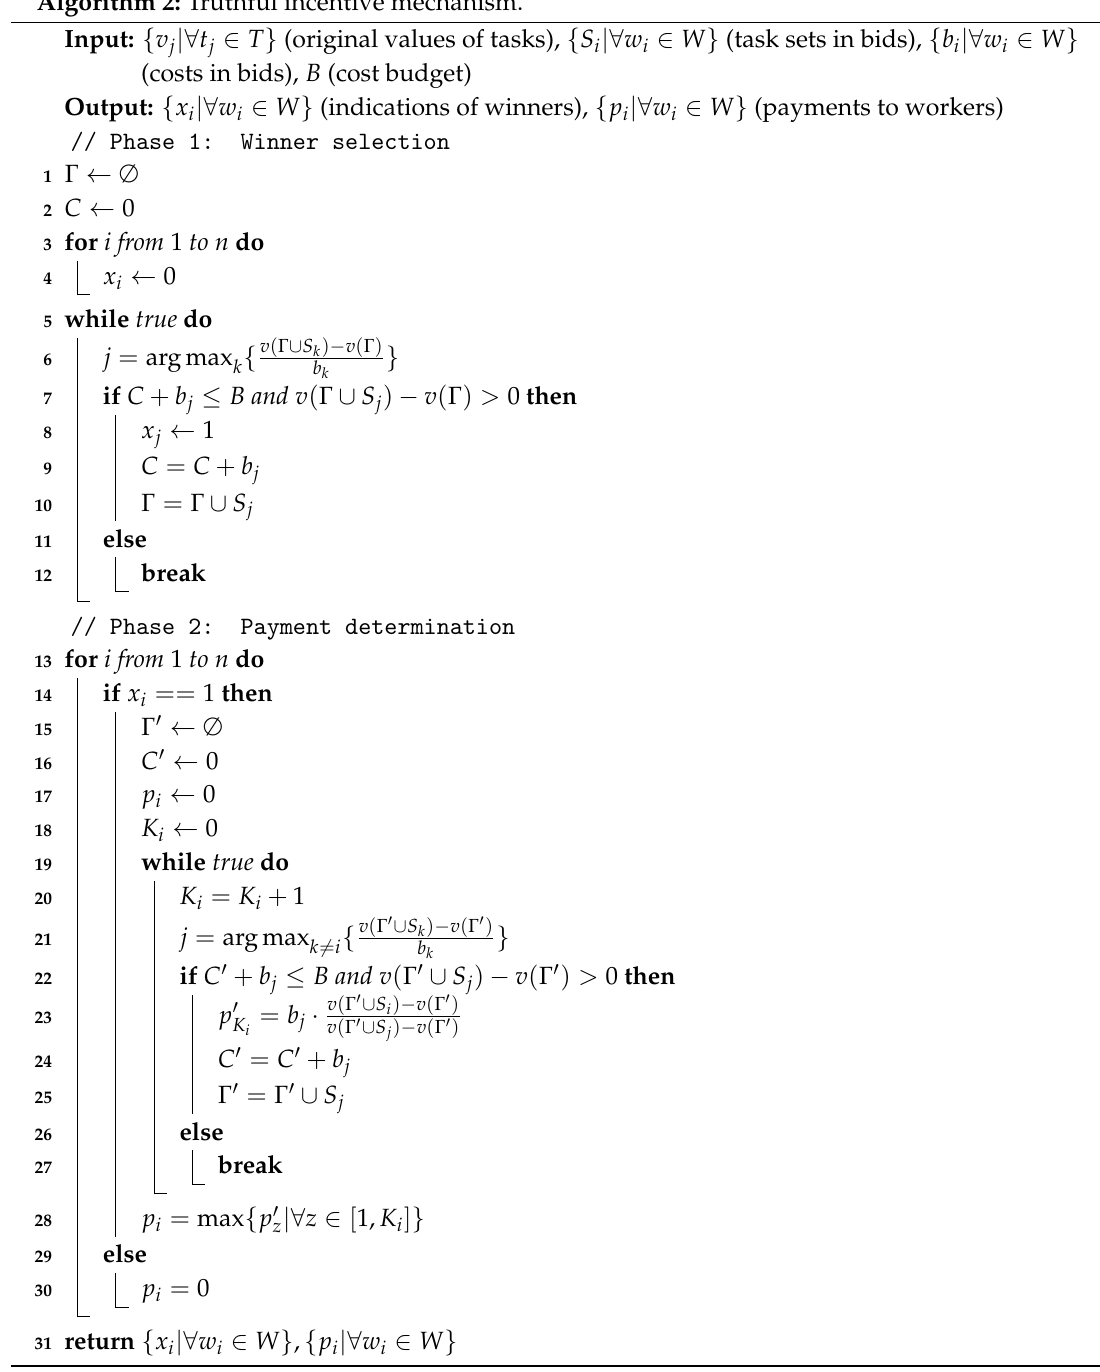
Algorithm 2: Truthful incentive